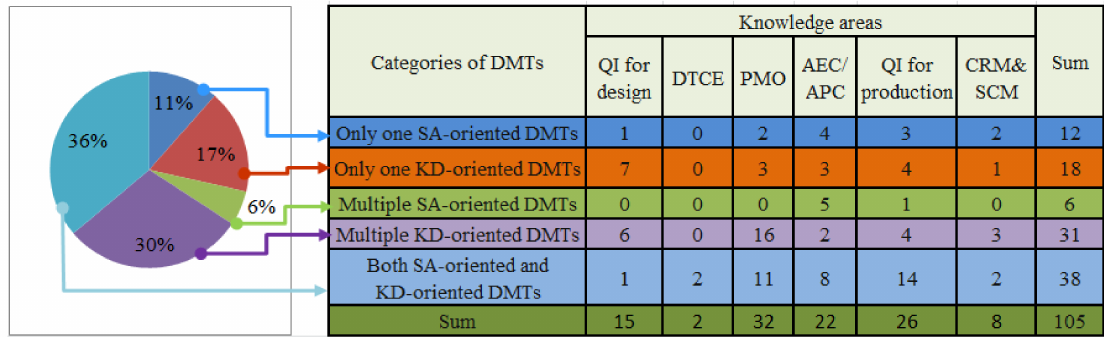
Figure 6. Different categories of DMTs for different knowledge areas (DMTs: data mining techniques).